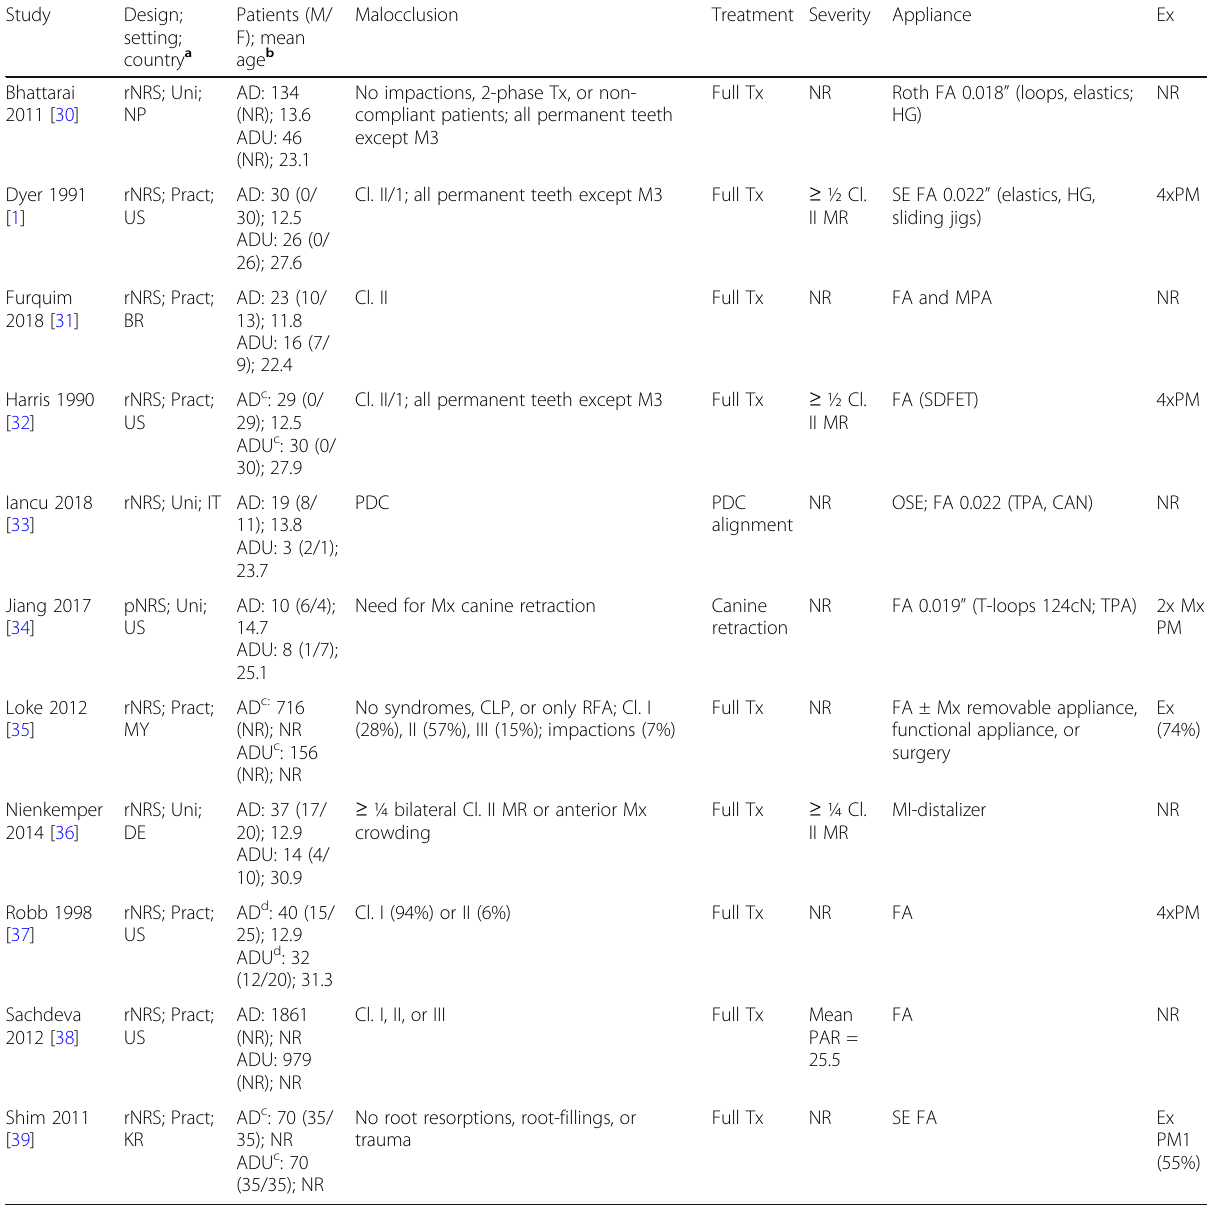
Table 1. Characteristics of included